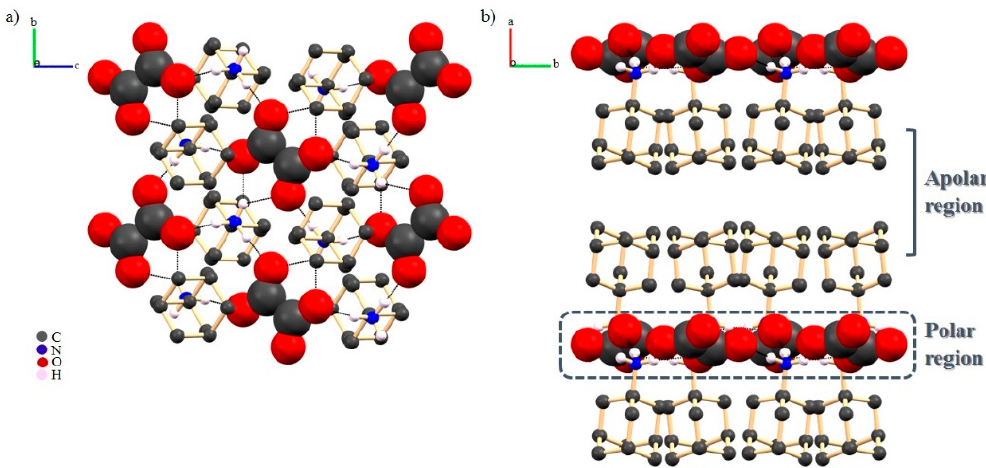
Figure 15. ( a ) view along a evidencing N-H + (ADA) ··· O - (OXA) interactions in a mosaic-like fashion mode; ( b ) view along b showing the lamellar effect. Aliphatic hydrogen atoms were omitted for clarity [76].